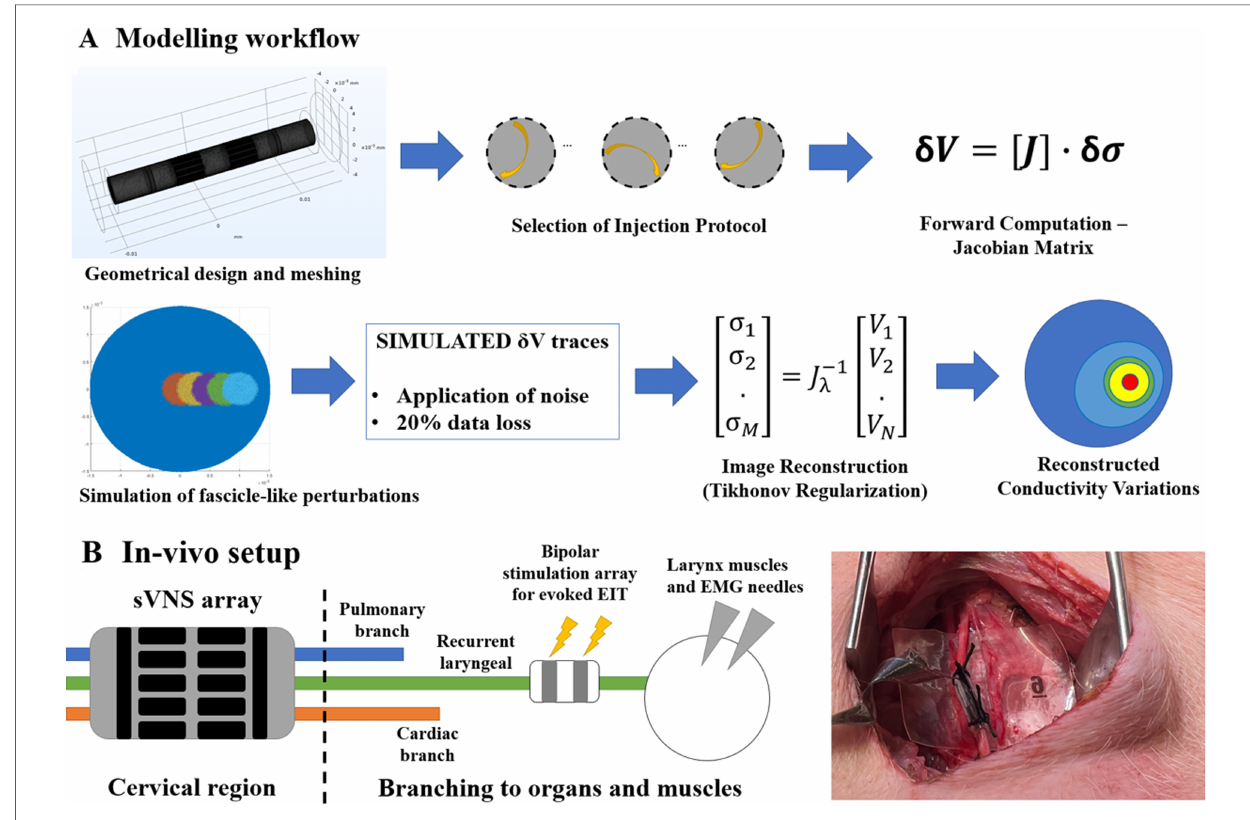
FIGURE 2 ( A ) Modelling work fl ow. A Jacobian matrix was computed from a given geometry, mesh and set of injection pairs. The Jacobian was used to generate simulated conductivity perturbations, retrieve corresponding voltages and perform image reconstruction. ( B ) In-vivo experimental setup. An sVNS nerve cuff was wrapped around the vagus nerve of a pig at the cervical level. A bipolar stimulation cuff was placed around the recurrent laryngeal branch for performing evoked-activity EIT, while EMG needles were placed at the level of the larynx. Image on the right shows application of the device on the vagus nerve in a